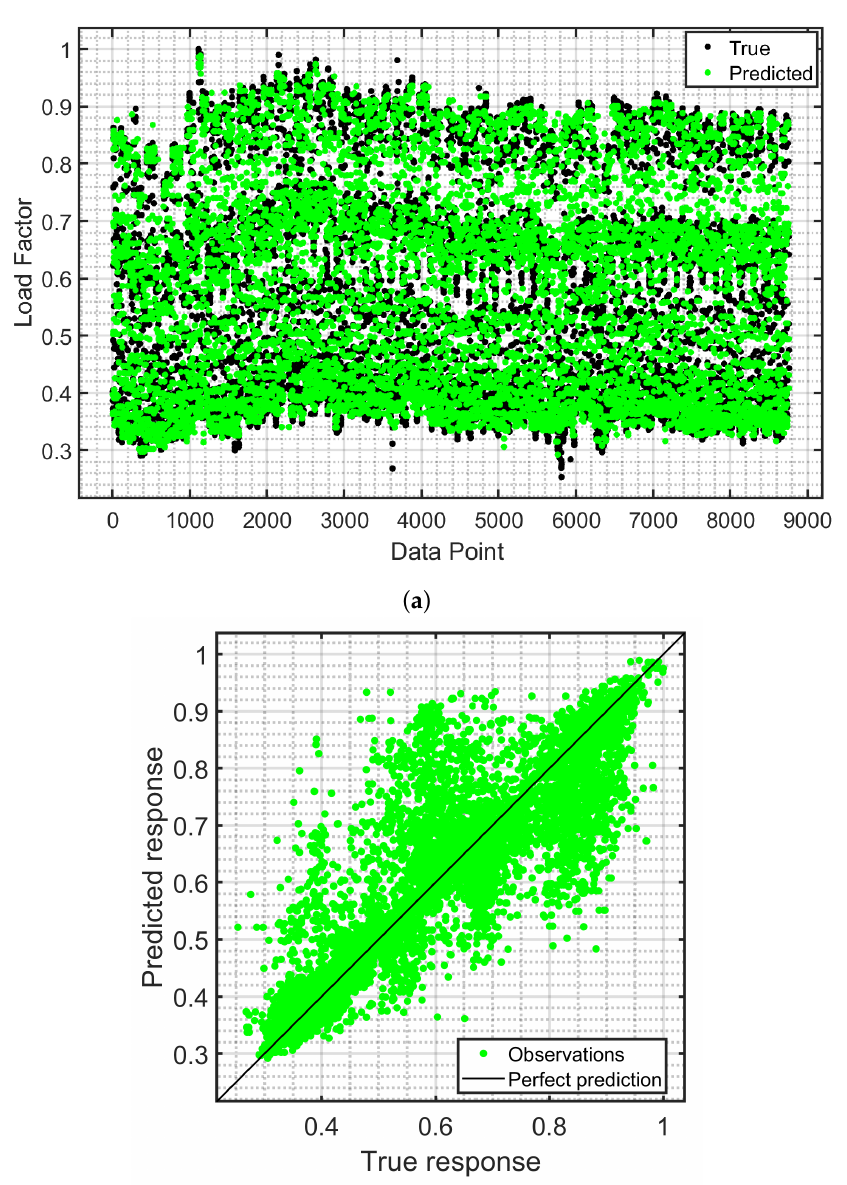
Figure 9. Results with Decision Trees. ( a ) Actual versus predicted values of Decision Trees. ( b ) Lin- earity analysis of Decision